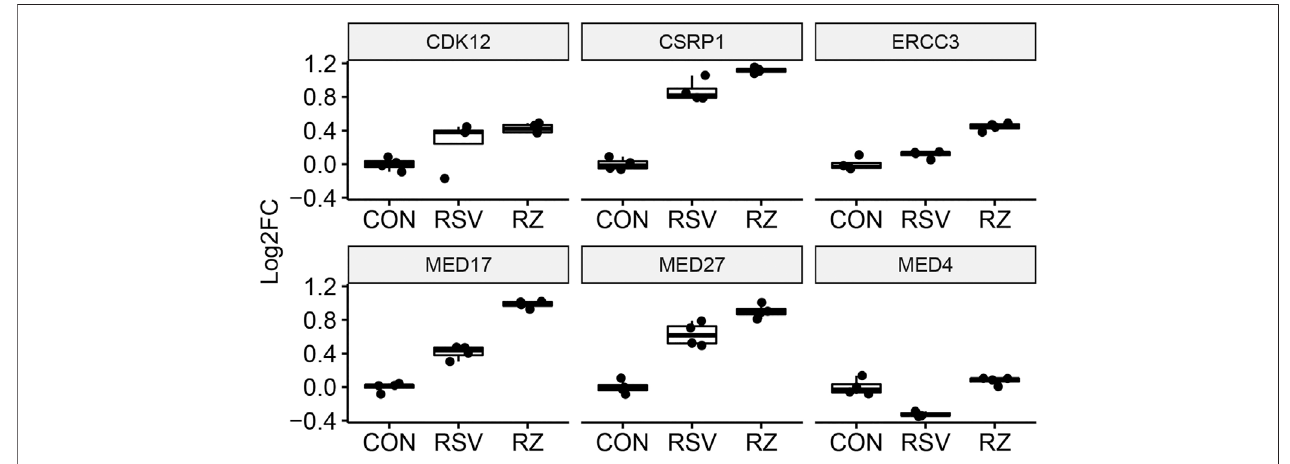
FIGURE 7 | BRD4 modulates the expression of MED. mRNA expression of BRD4-interacting MED complexes. For each, log 2 FC values are plotted as 25-75% interquartileranges.Adjusted p- valuesofRSVvsRSV+ZL0454treatmentareasfollows: MED4 (cid:1) 0.000144; MED27 (cid:1) 0.00159; CSRP1 (cid:1) 0.00102; MED17 (cid:1) 2.1E-25; ERCC3 (cid:1) 2.08E-8; and CDK12 (cid:1) NS.